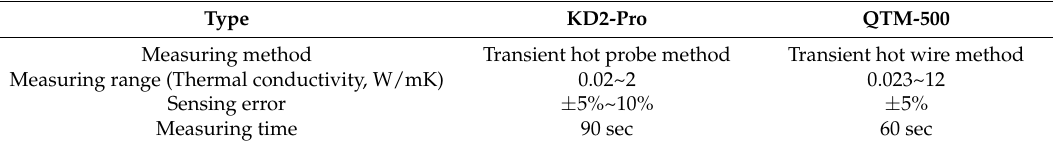
Table 2. Specifications of KD2-Pro and QTM-500.